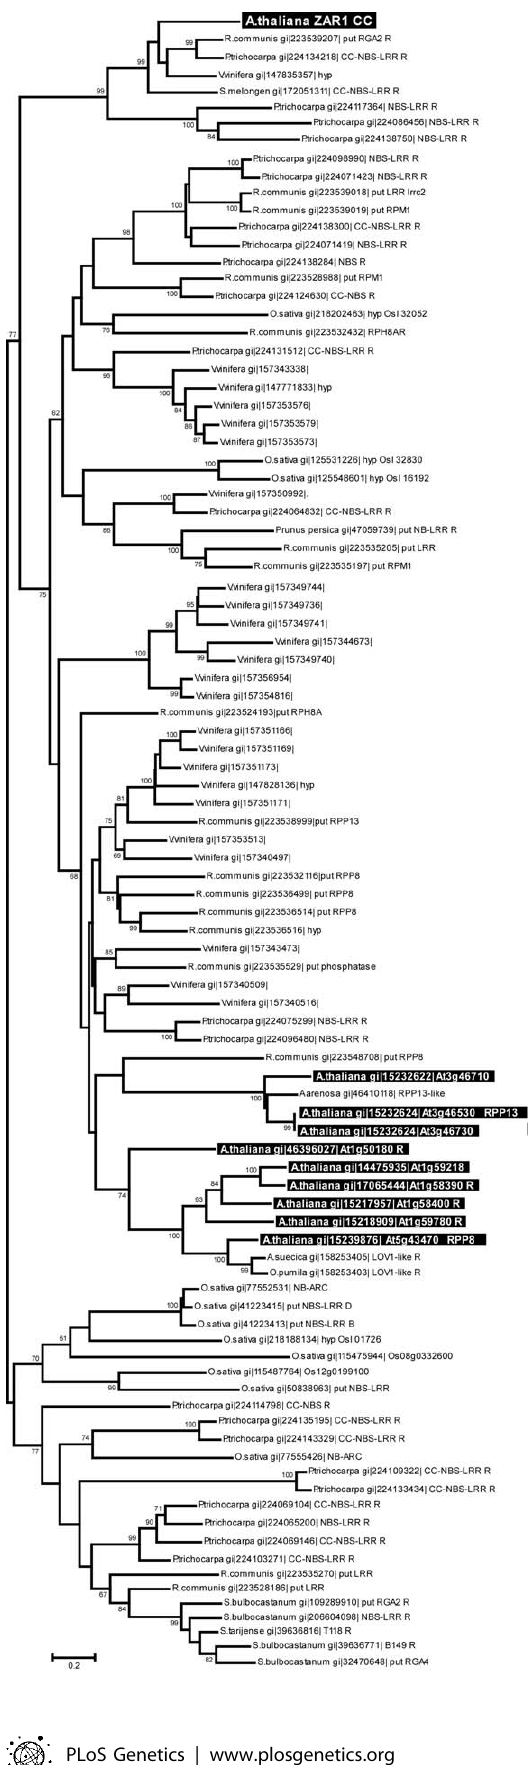
Figure 5. Evolutionary relationships of 95 ZAR1 coiled-coil domain homologs. The evolutionary relationships of the homologous amino acid sequences were inferred using Neighbor-Joining, with the robustness of the tree assessed via bootstrapping (500 replicates, with bootstrap values greater than 60% shown above the appropriate nodes). The tree is drawn to scale, with branch lengths scaled to evolutionary distances (scale shown at the bottom of the tree). All Arabidopsis ZAR1 coiled-coil domain homologs are shown in reverse type, while the ZAR1 sequence is found at the top of the tree. The data were parsed to remove redundant sequences as described in the Materials and Methods. ‘‘put’’ indicates a putative R protein while ‘‘hyp’’ is hypothetical. The major structure of this tree (e.g. clustering of ZAR1 and other Arabidopsis homologs) is identical to that observed in trees produced by maximum likelihood and maximum parsimony analysis (data not shown).